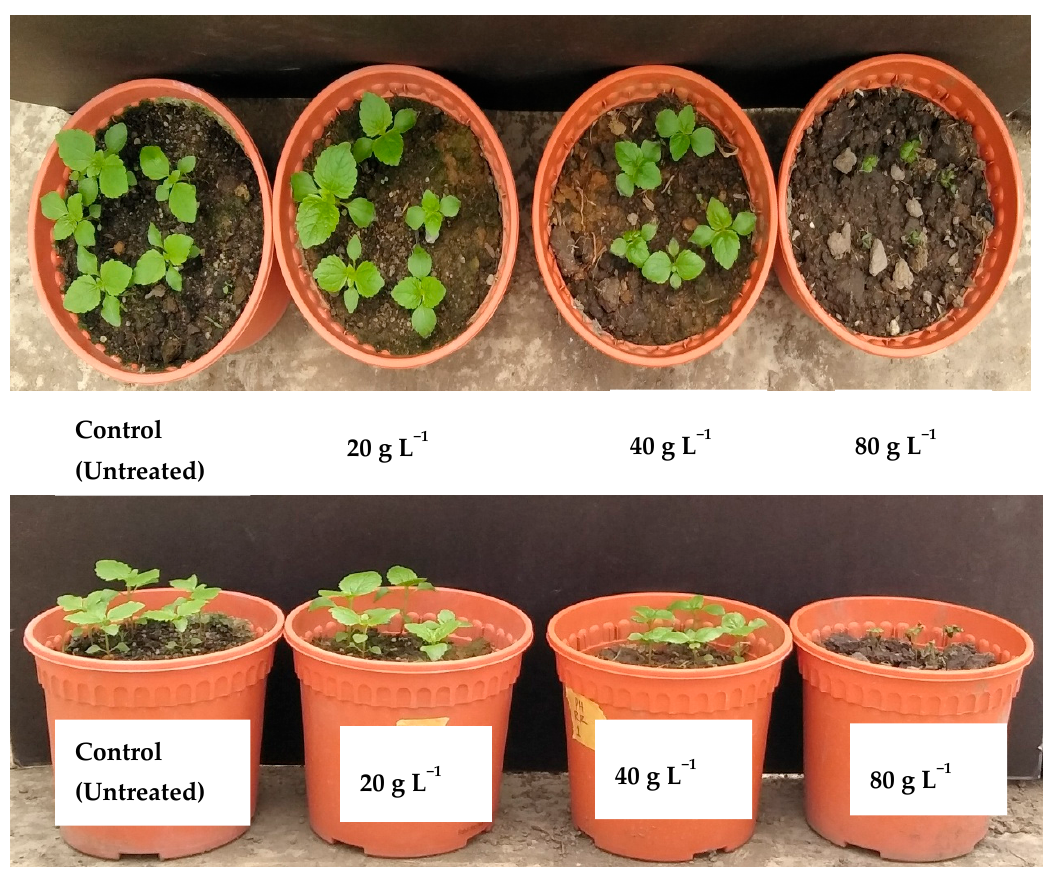
Figure 3. Effect of P. hysterophorus extract on A. conyzoides at 24 h after spray.